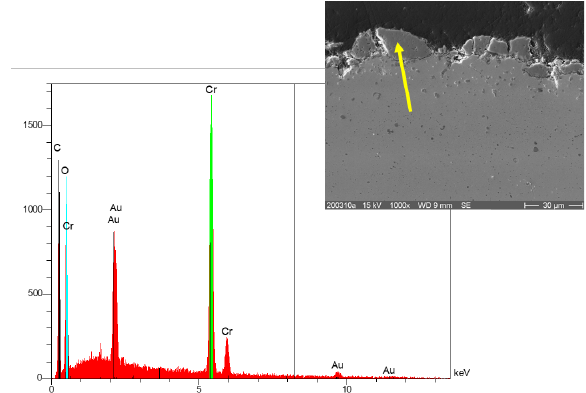
Figure 9. SEM micrograph of oxide scale formed on the surface of Cr-Ni after oxidation at 1200 °C in steam for 20 hours accompanied with EDS measure- ment of the marked